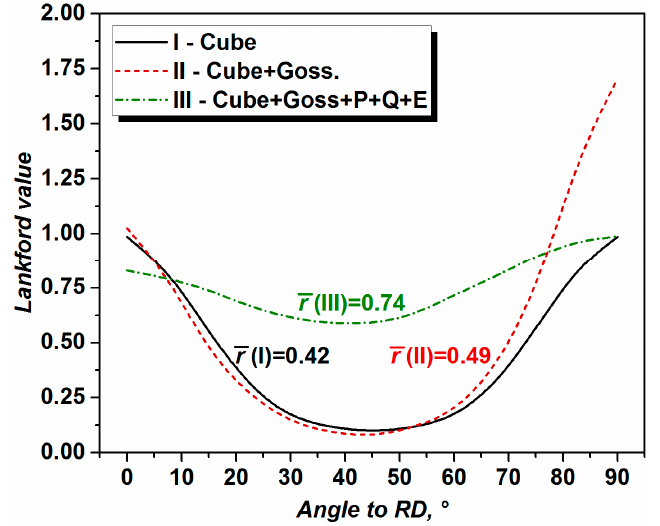
Figure 9. Lankford value profiles calculated for three texture types of Figure 8.